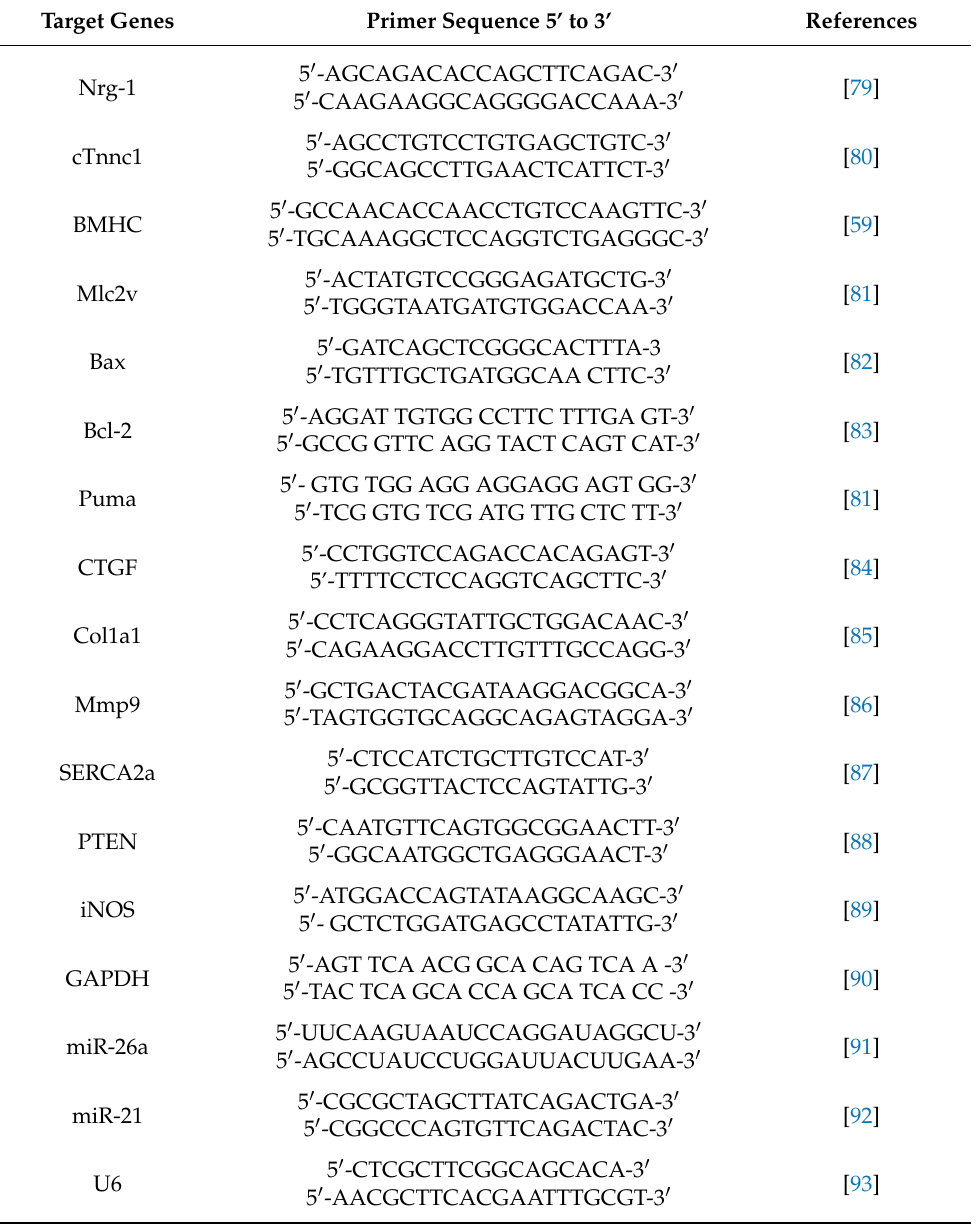
Table 2. Sequences of primers used for RT-PCR in this